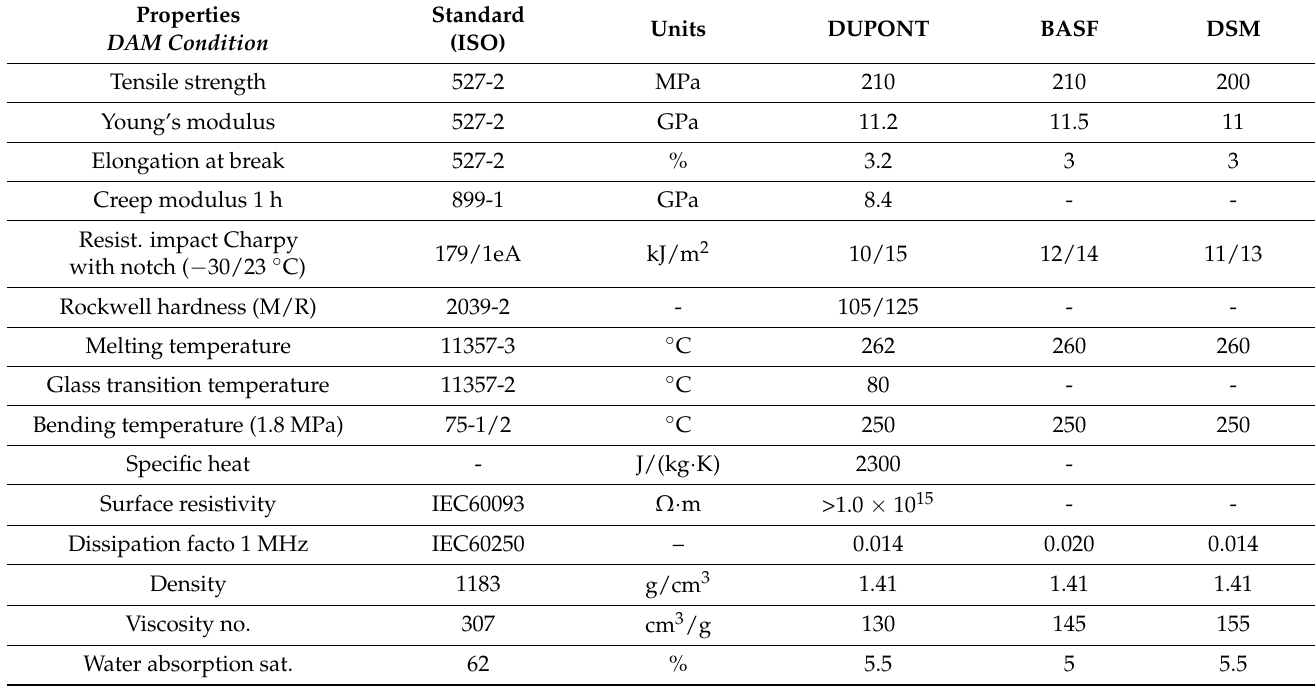
Table 2. General properties of PA6.6GF35 (CAMPUS. (2013) CAMPUS plastics. (Online). http: //www.campusplastics.com/ (accessed on 13 September